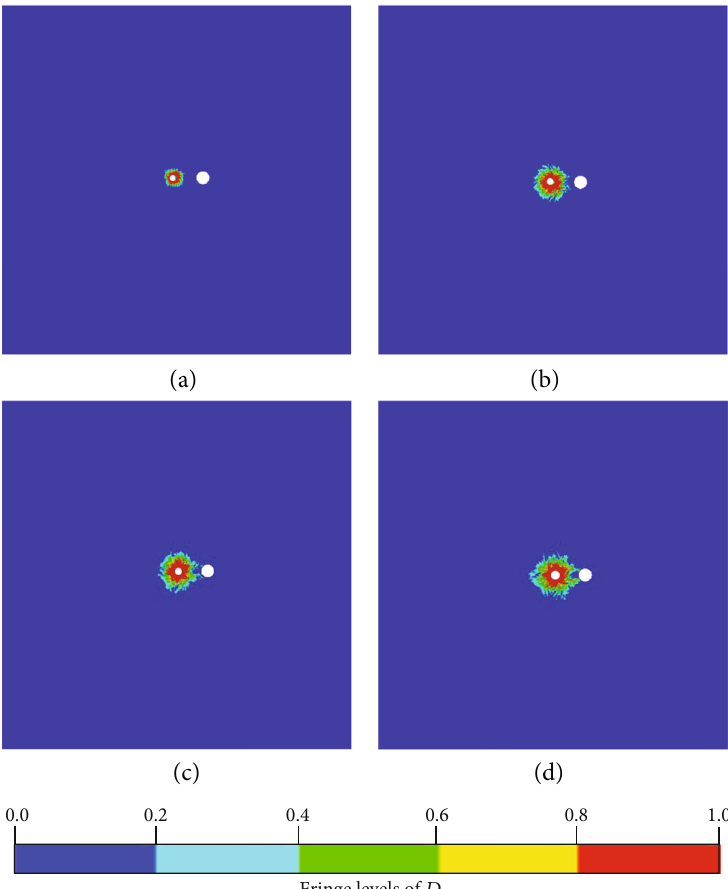
Figure 9: Compression damage of prime cut blasting under di ff erent diameters of the charge hole: (a) scheme 5, (b) scheme 11, (c) scheme 12, and (d) scheme